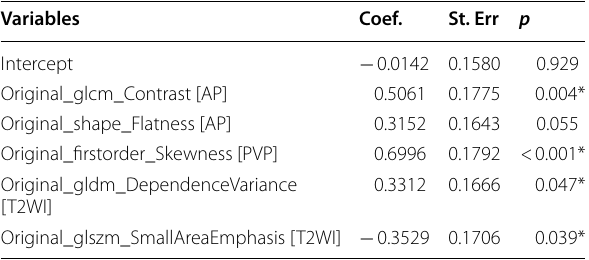
Standard error (Std.Err); Coefficient (Coef.)